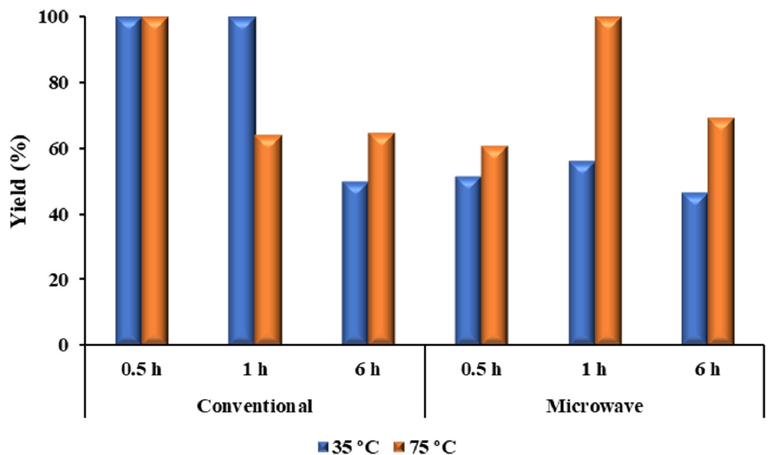
Figure 7. Conventional and microwave (MW) irradiation heating methods vs. time on the Suzuki- Miyaura (SM) reaction.